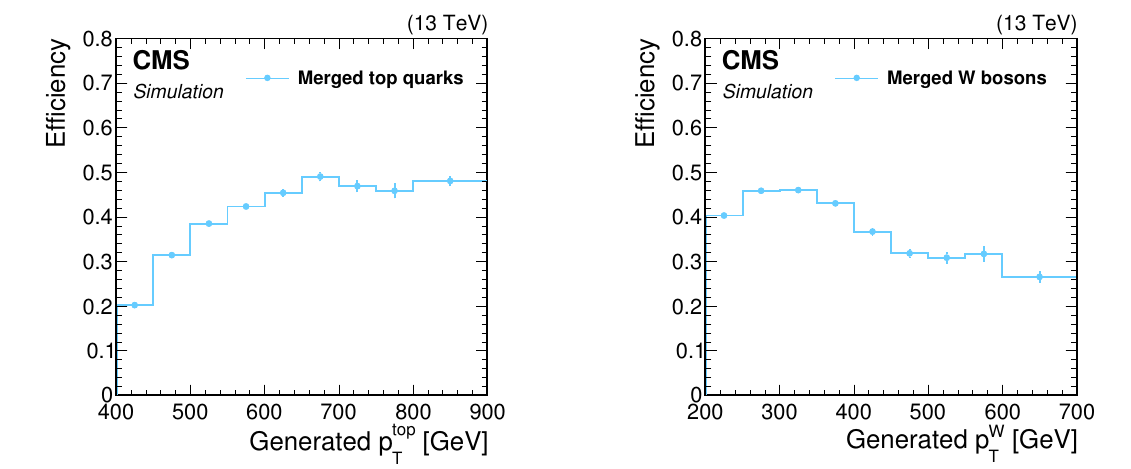
Figure 2 . E(cid:14)ciencies in MC simulation for identifying the quark decays of top quarks (left), and W bosons (right), as a function of the p T of the generated top quarks or W bosons to which they were